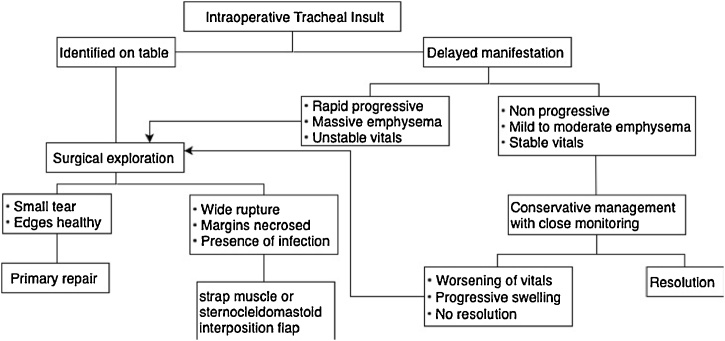
management of tracheal injury [18].